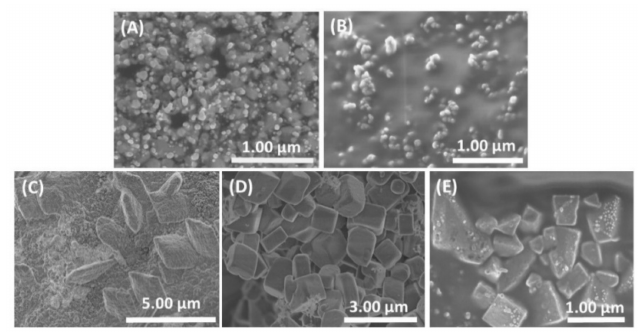
Figure 5. SEM images of the particles suspended in the aqueous wastes, where ( A ), ( B ), ( C ), ( D ) and